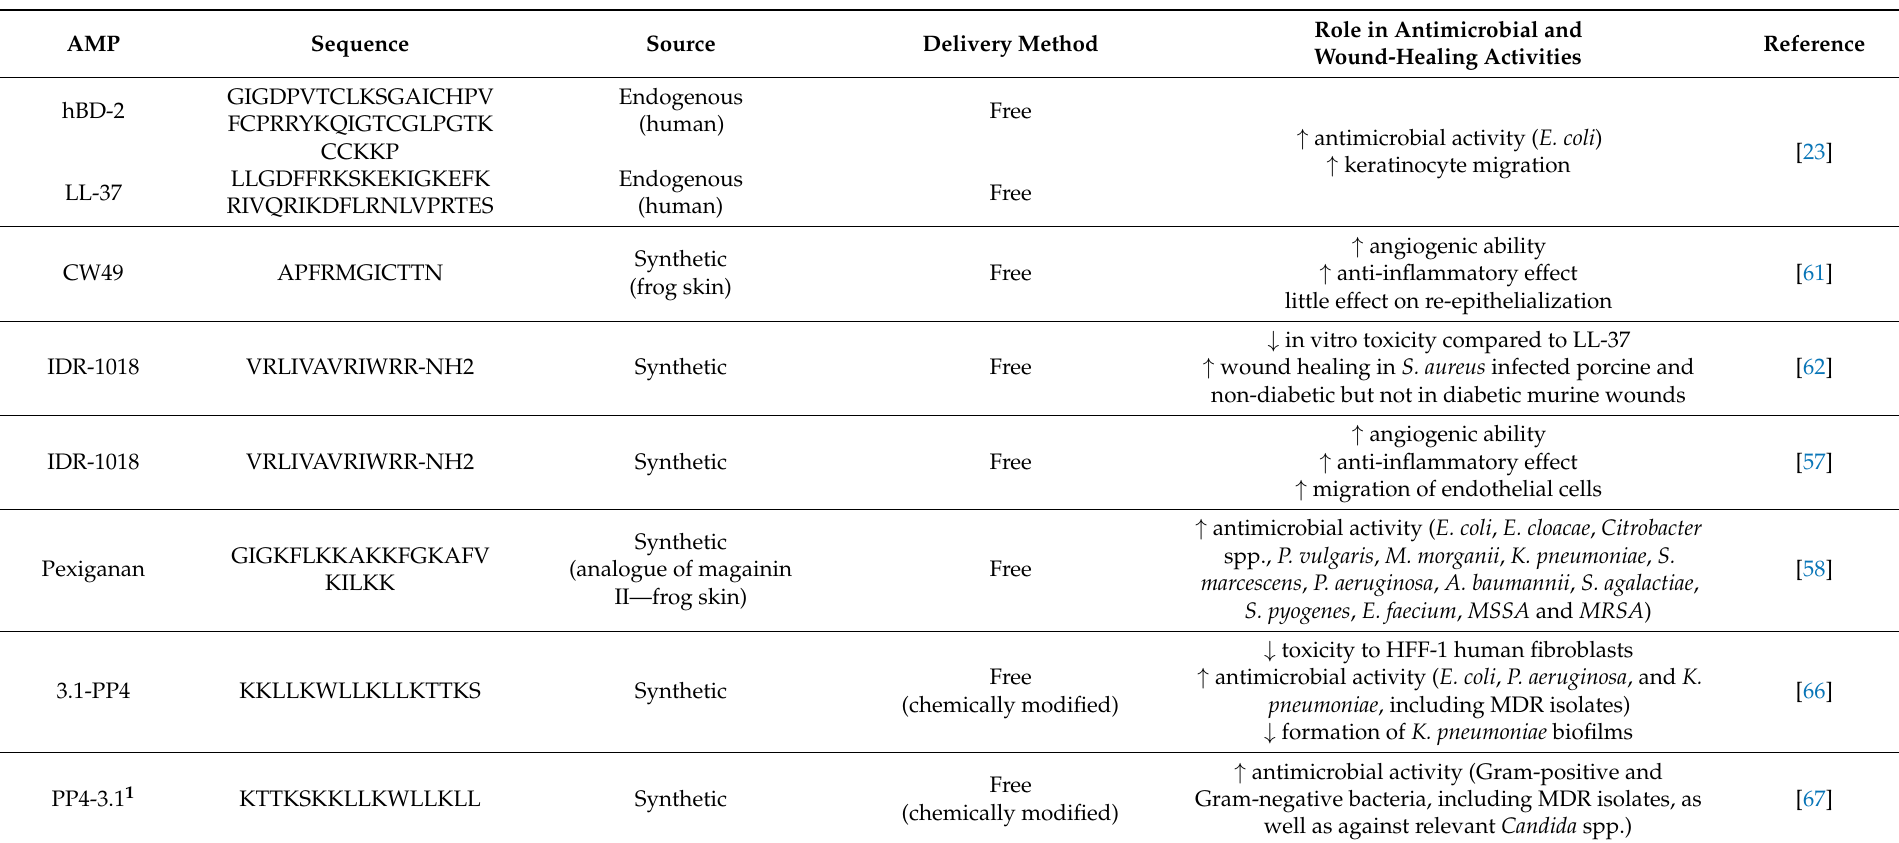
Table 3. Free AMPs being applied as promising therapies for infected chronic wounds and their respective roles in antimicrobial and wound-healing activities. All AMPs are presented according to the following criteria: (1) free vs. chemically modified; (2) endogenous vs. synthetic; and (3) alphabetic order. AMP sequences are presented using the one-letter amino